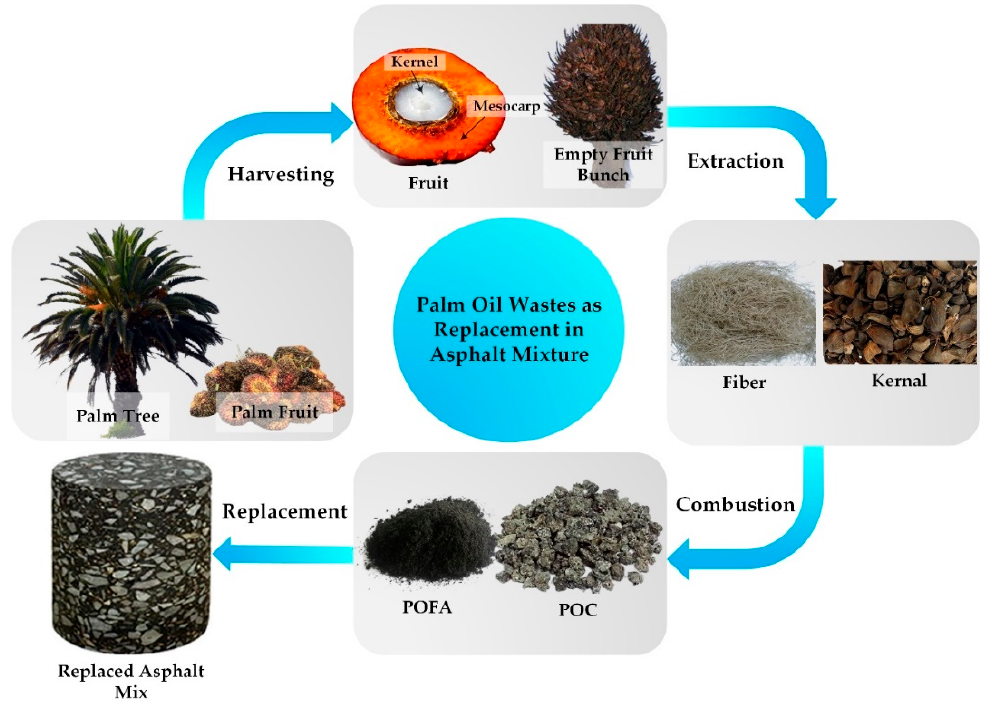
Figure 10. POC for asphalt mixture [19]